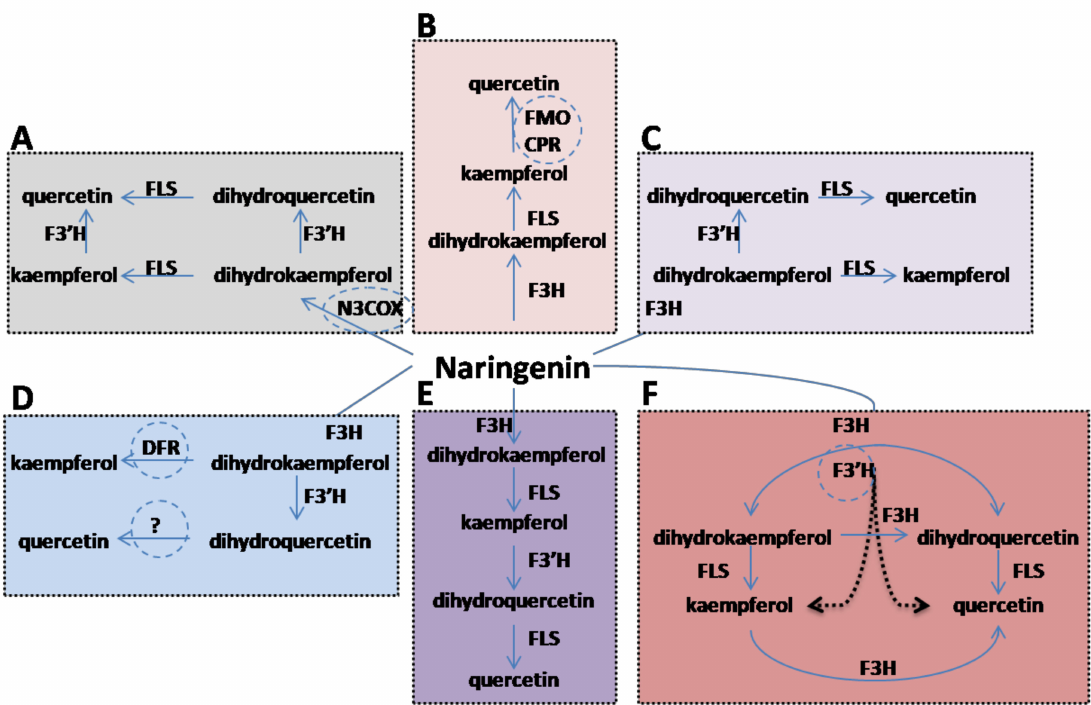
Figure 1. Schematic representation of the flavonoid biosynthetic pathway proposed for significant production of kaempferol and quercetin in different organisms. Naringenin is a substrate used by all the organisms using different enzymes for conversion to their respective products. ( A ) represents the proposed pathway in yeast using the N3COX gene converting naringenin into dihydrokaempferol. ( B ) shows the flavonoid pathway developed in microbes with the expression of the FMO and CPR gene catalyzing kaempferol into quercetin. ( C ) the flavonoid pathway in Arabidopsis shows that F3 (cid:48) H catalyzes dihydrokaempferol into dihydroquercetin while, ( D ) in Lotus, DFR converts dihydrokaempferol into kaempferol, instead of the FLS enzyme. ( E ) shows F3 (cid:48) H converting kaempferol into dihydroquercetin in blackberry and ( F ) is our proposed pathway for flavonoid synthesis in yeast using the rice F3H